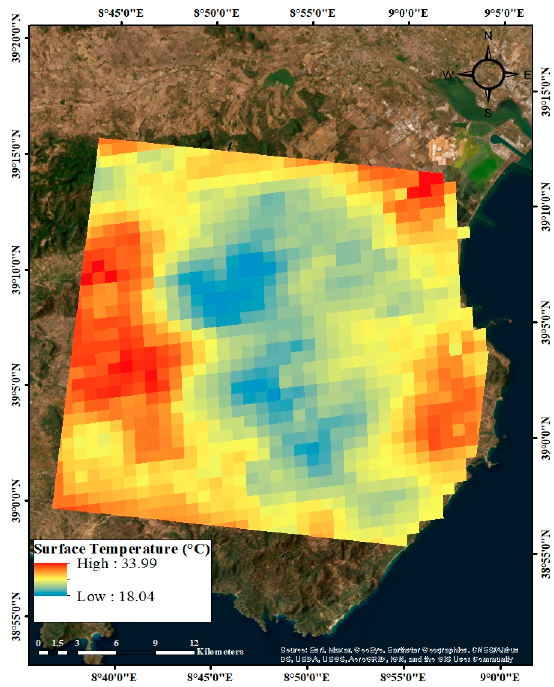
Figure 9. Tree canopy temperature map, October 2021.